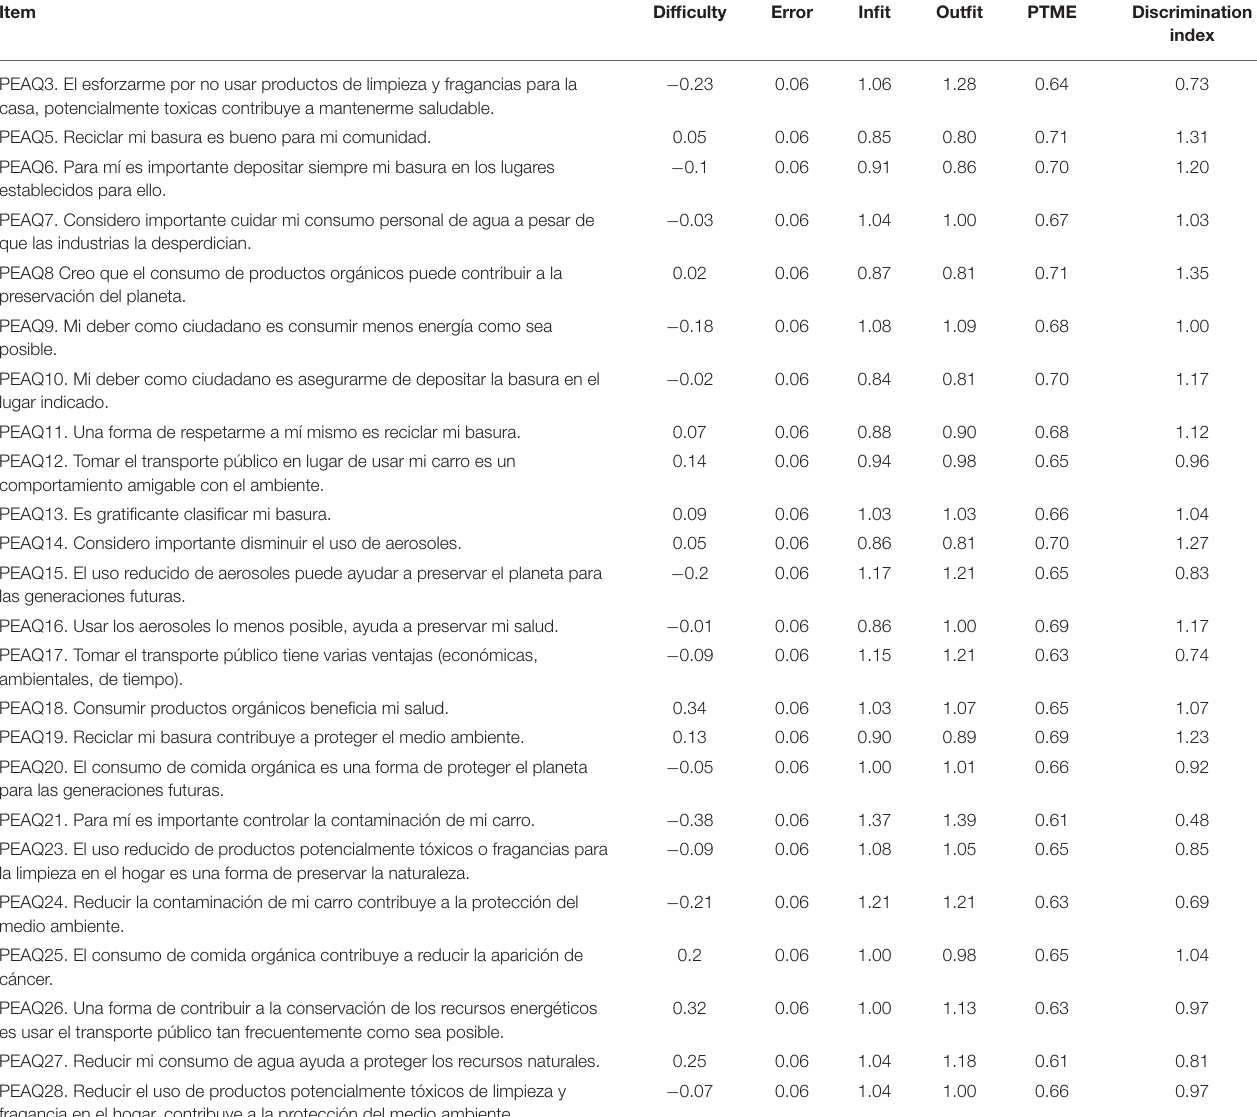
TABLE 2 | Goodness-of-fit statistics Rasch model study PEAQ scale Colombian version ( N = 415). Item